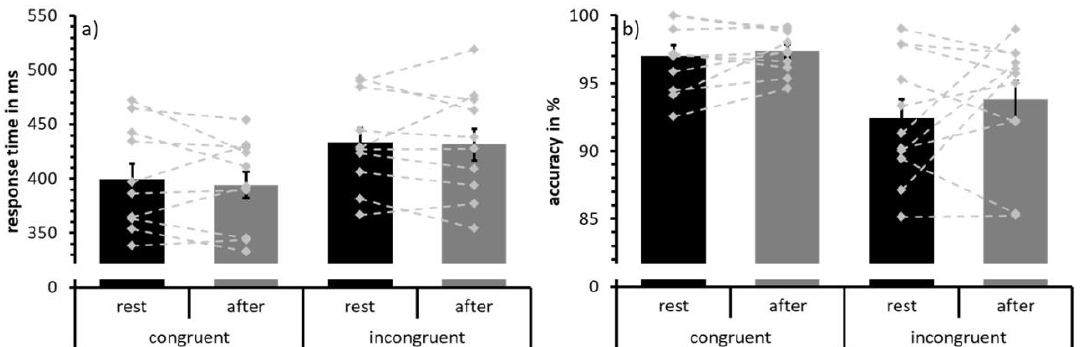
Figure 2. Mean response times ( a ) and response accuracy ( b ) to congruent and incongruent trials at rest (black) and following acute exercise at moderate intensity (grey). Error bars depict standard error values. The DotPlot visualizes the individual data (light grey) for the congruent and incongruent condition as well as the change from rest to after-exercise (dashed lines).